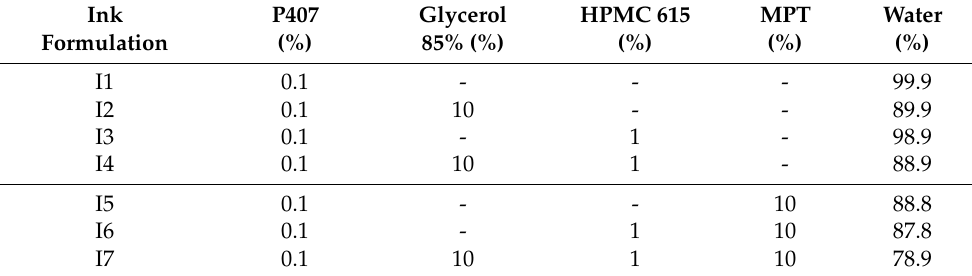
Table 1. Composition of investigated ink formulations ( w / w